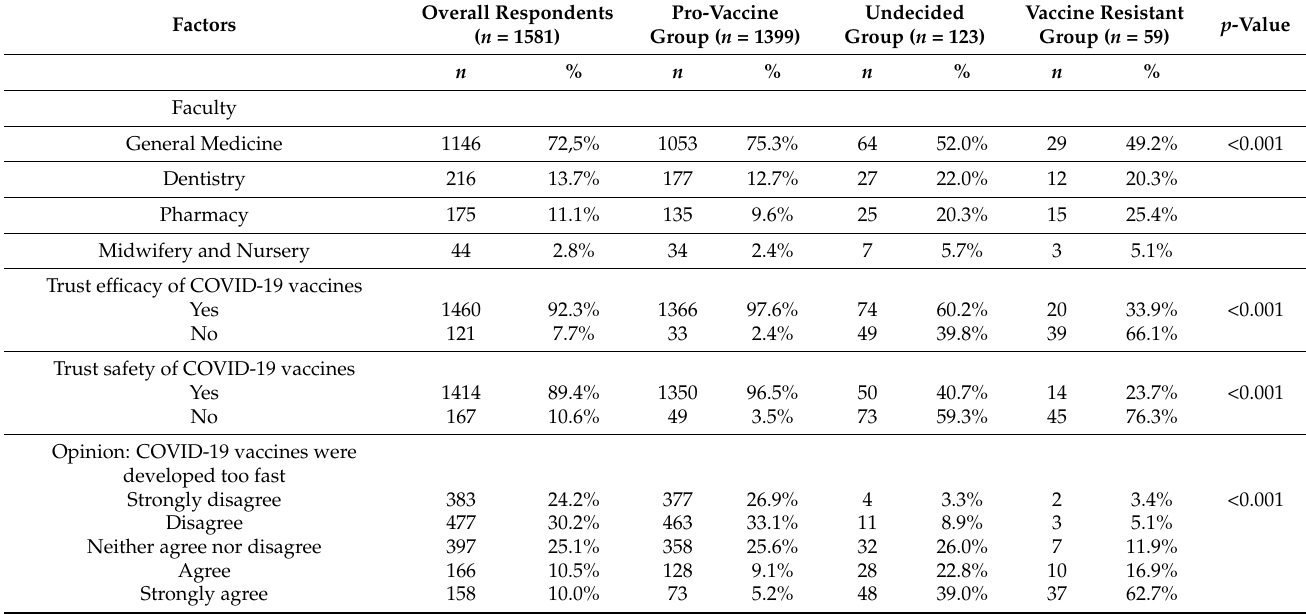
Table 1. Factors associated with vaccine acceptance in the respondent population comprising medical students.